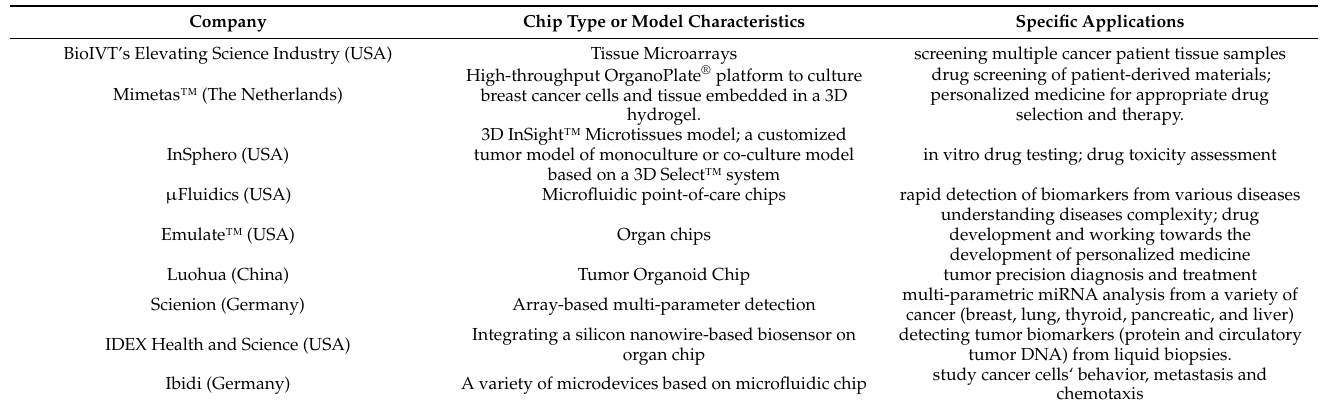
Table 3. The pharmaceutical and biotechnological companies and the explored breast tumor-on-a-chip systems.